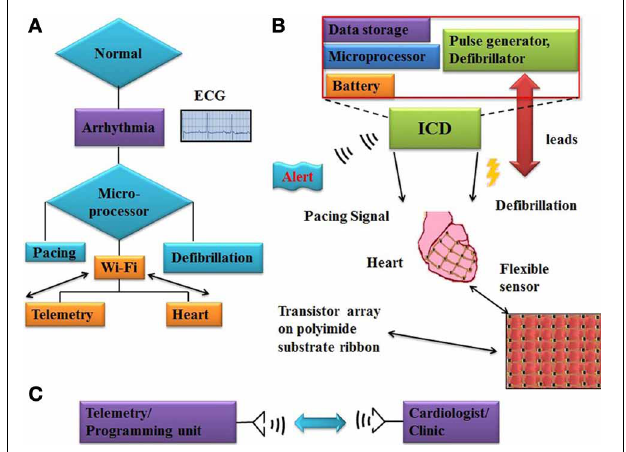
FIGURE 2 | Work flow chart of ICD functioning and flexible sensor array system(A)flowchartillustratesworkingprincipleofICDandalertsignal activation, microprocessor trigger pacing or defibrillation impulse on arrhythmias onset (B) major internal building blocks of ICD device, like battery, microprocessor, and RAM memory. Flexible sensor array which consisting of transistors (FETs) fabricated on polyimide flexible substrate. (C) Block diagram of telemetry/programming unit to record clinically relevent data and connected with cardiologist/clinic for any